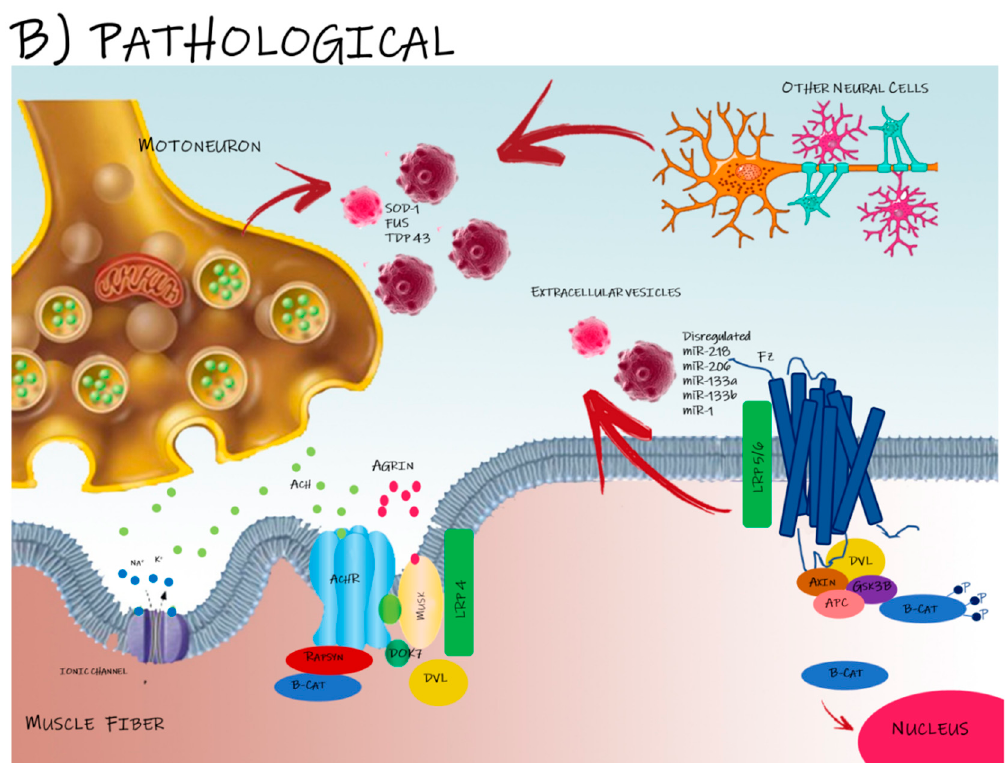
Figure 1. The role of extracellular vesicles (EVs) in the motoneuron–muscle communication. ( A